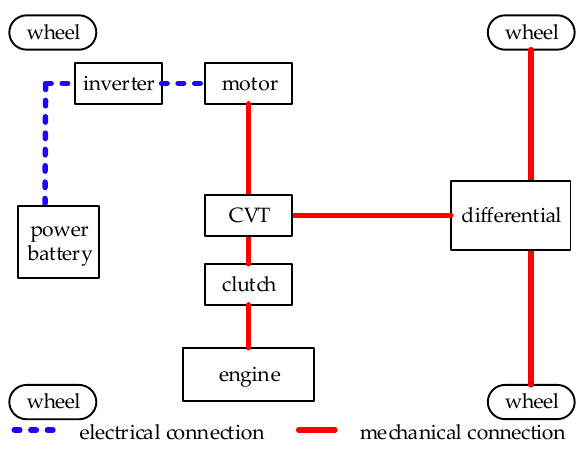
Figure 1. The configuration of parallel hybrid electric vehicles.